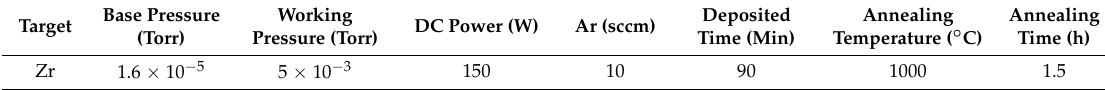
Table 2. Preparation parameters of nanocrystal ZrO 2 thin film. (DC: Direct Current).